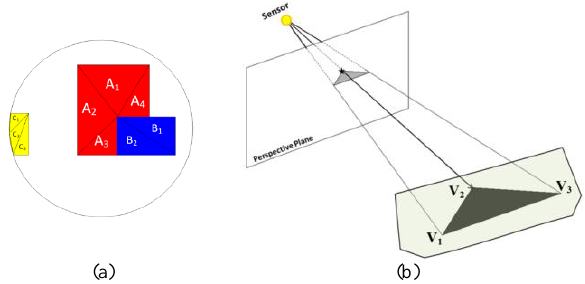
Figure 9. (a) Converting the polygons to triangles; (b) Transformation of the triangles into their own 3D polygon planes